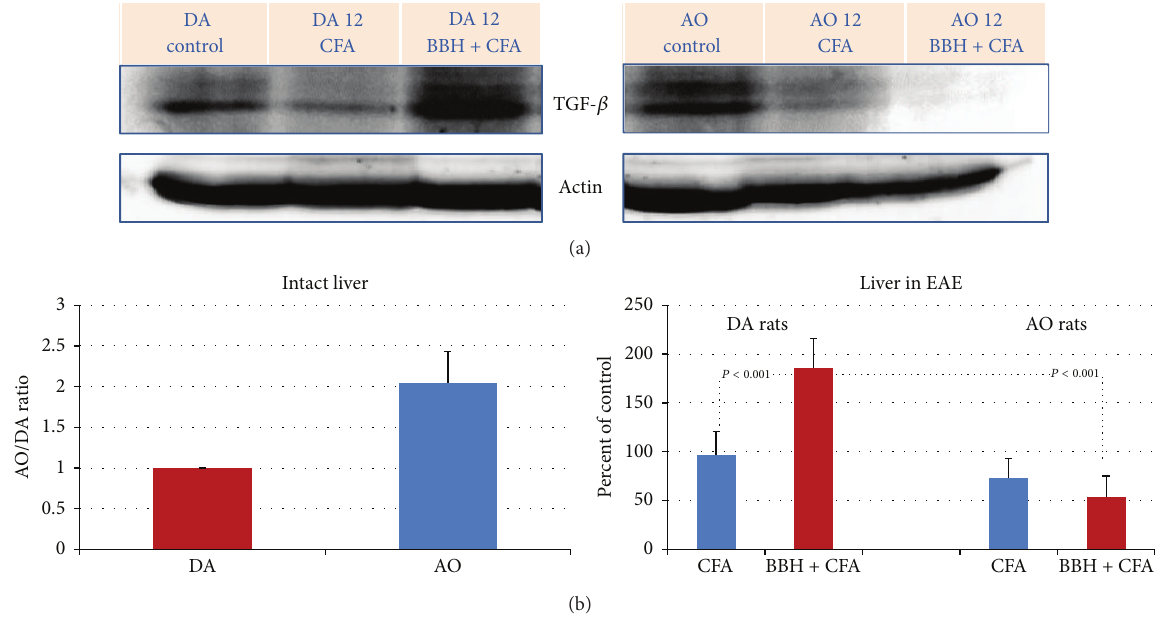
Figure 4: Expression of TGF- 𝛽 in the livers of EAE-prone DA and EAE-resistant AO rats. (a) Representative western blots indicate the TGF- 𝛽 protein ( ∼ 44kD; range 35–55 kD), detected by mouse anti-rat antibody to IL-6 in the liver samples obtained from intact rats and rats treated by bovine brain homogenate (BBH) and complete Freund’s adjuvant (CFA) or by CFA at the time of first attack in EAE-prone rats (day 12). As a loading control the blots of 𝛽 -actin protein (37–50 kD) are shown. (b) Relative protein expression is shown as AO/DA ratio (intact liver) and as the percent of control (liver in EAE). All band densities were normalized corresponding to 𝛽 -actin. Analyses were made in tissue samples, prepared as a pool from 3 rats in three independent experiments. Data represent mean ±